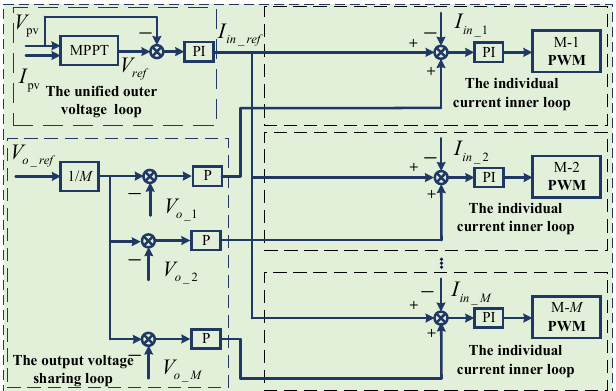
Figure 4. Traditional control strategy diagram of IPOS combined converter. MPPT: Maximum power point tracking, PI: Proportion Integral, PWM: Pulse width modulation